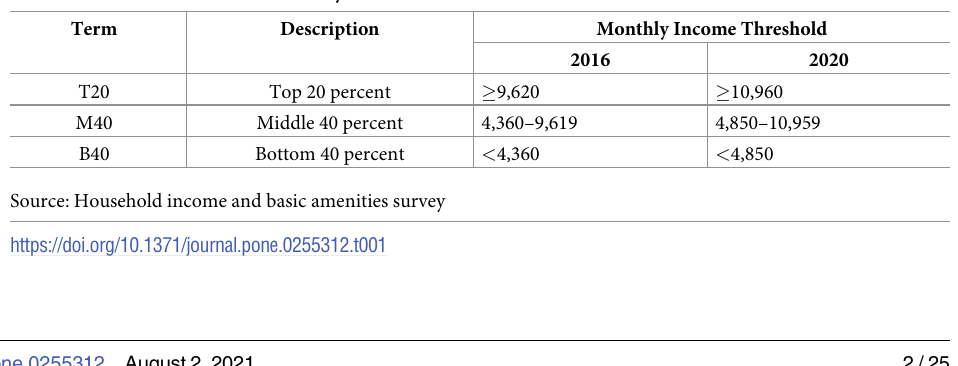
Table 1. Income classification for